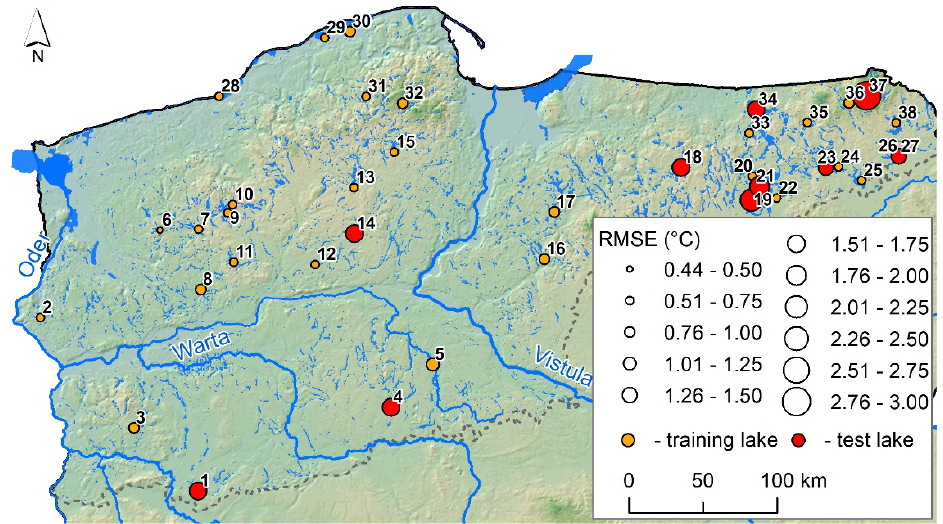
Figure 8. Spatial variability of RMSE values for the training sample and test sample in the random forest model. Orange color signifies training lakes, and red color marks test lakes. Numbering of lakes (1–38) according to Supplementary Table S1.